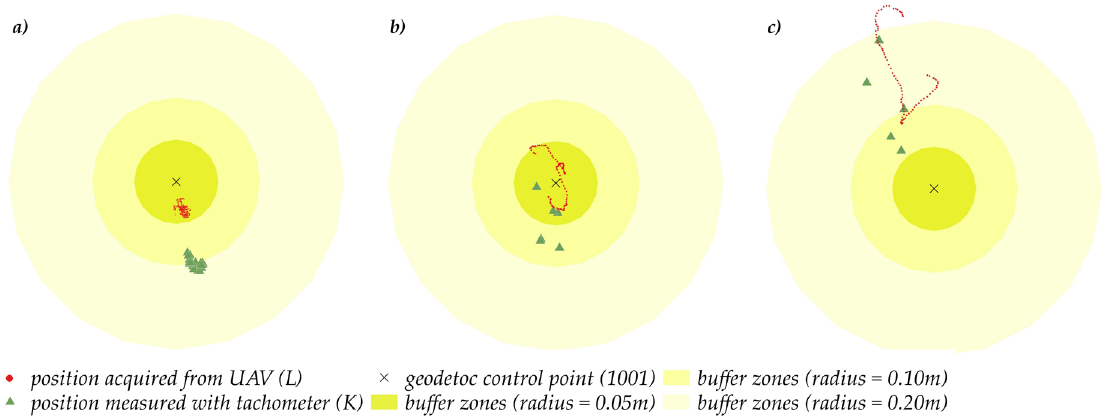
Figure 8. The spatial distribution of UAV positions at each examined altitude ( a ) altitude H = 1. 5 m ;